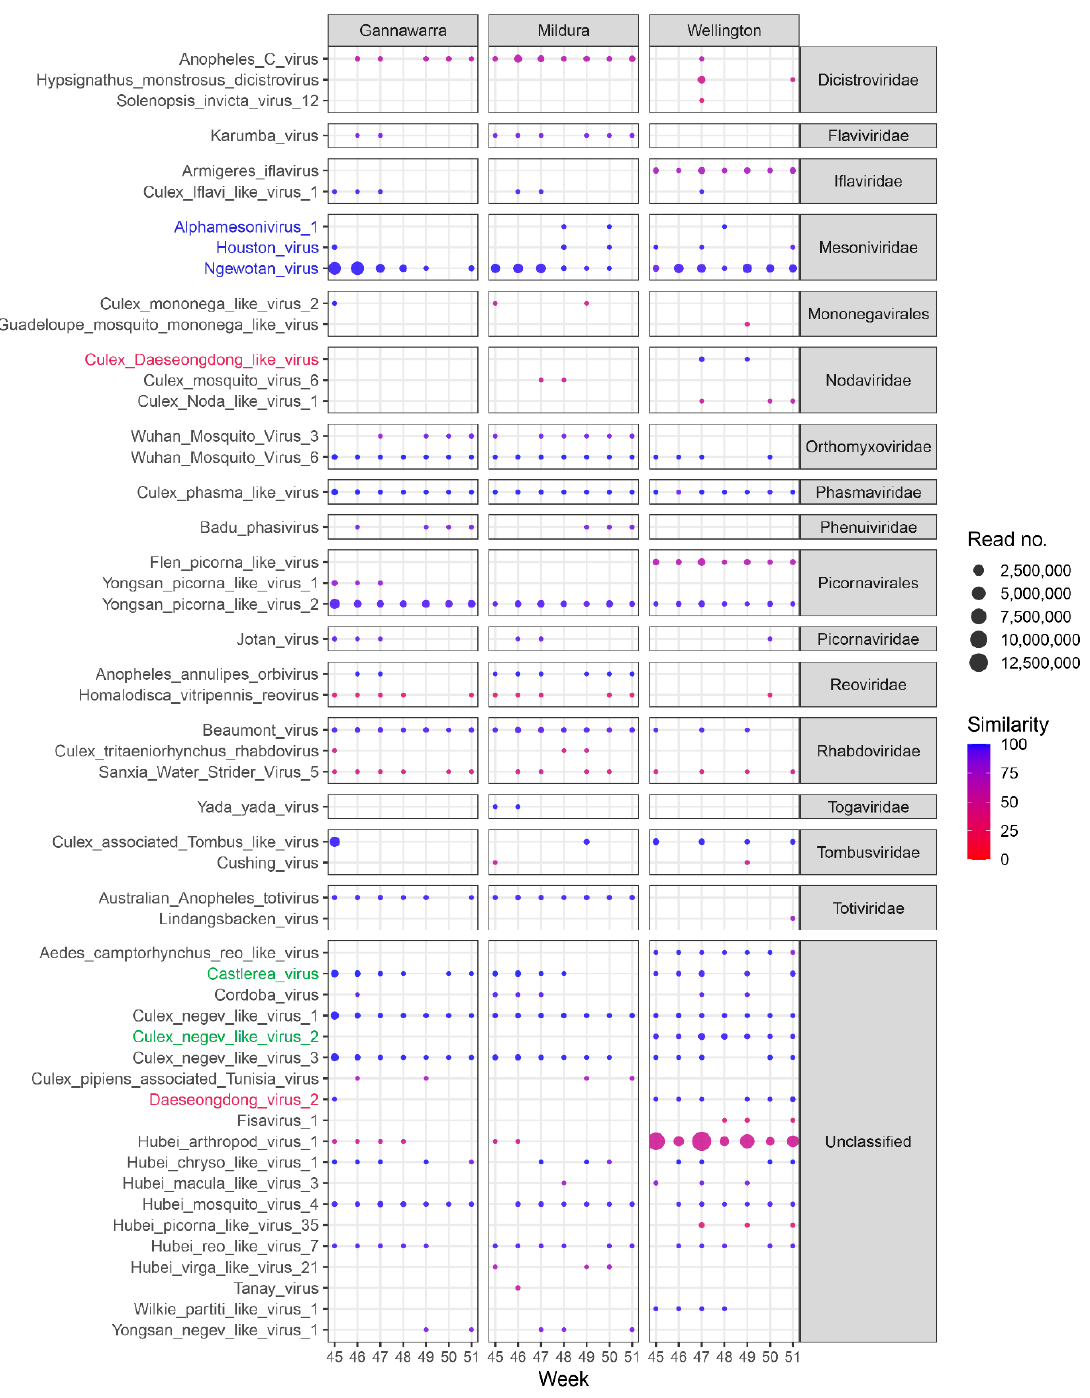
Figure 7. Results of the virome analysis showing the BLASTx match for contigs assembled from traps in Gannawarra, Mildura and Wellington over seven weeks (45–51) in 2016. The dot colour indicates the similarity of the contigs to the virus GenBank sequence, as measured by the percentage of identical amino acids. The dot size indicates virus abundance, which is based on the number of reads mapping to the matching contigs. Coloured names indicate highly similar or identical viruses (Figure S3) that likely represent a single detection. The arboviruses detected using the targeted database (Figure 5) are not included here.